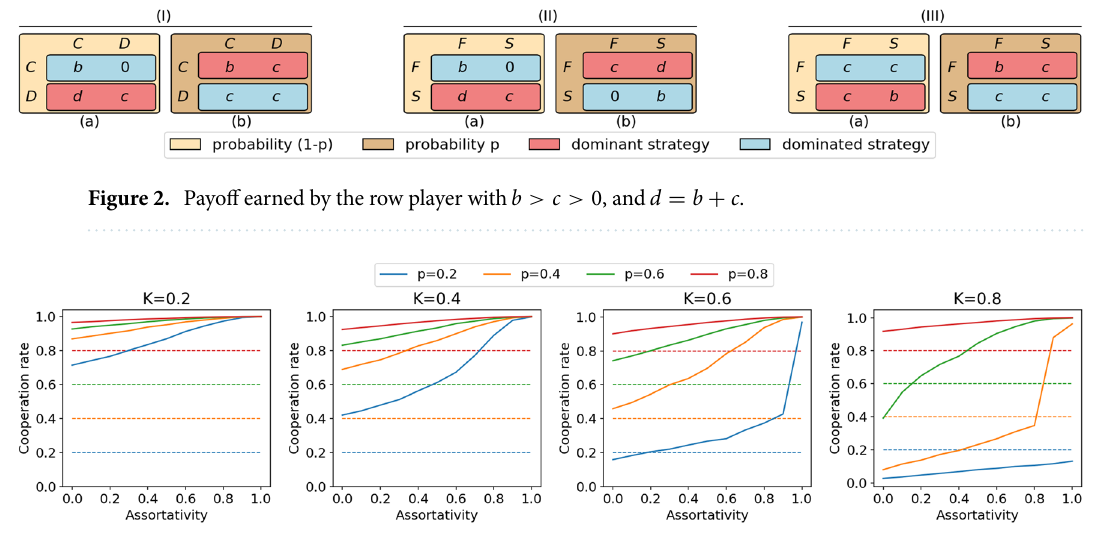
Figure 3. Average cooperation rate varying assortativity in cognition. Each subplot refers to a specific value of K . Solid lines represent the average rate of cooperation under intuition, dashed lines represent the average cooperation rate under deliberation, i.e., the value of p . Each color refers to a specific value of p . Results are based on simulations over 5000 periods, with 500 agents, payoffs b = 4 and c = 1 , and learning rate α = 0.5